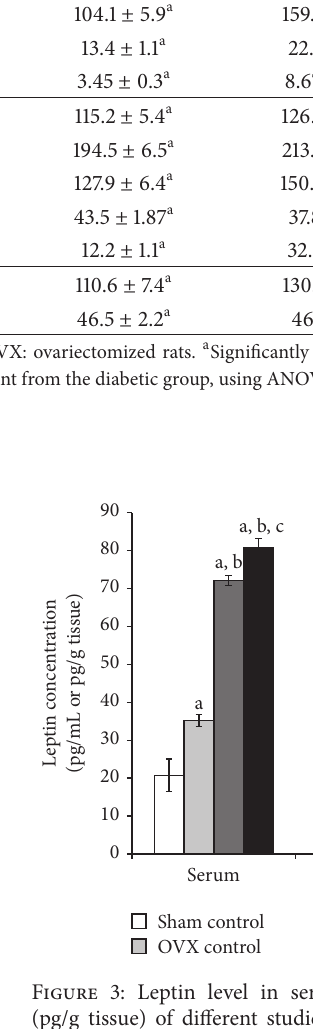
Table 1: Parameters of glucose homeostasis, lipid profile, and hepatic lipid content of different studied groups at the end of the study. Parameter Sham control Diabetic Fasting blood glucose (mg/dl)